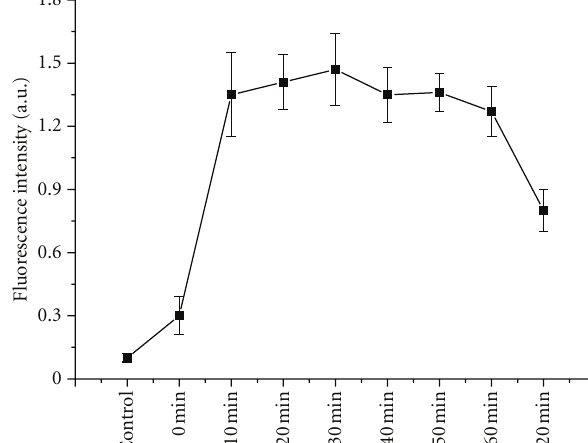
Figure 8: Change of percentage of apoptotic cells after light therapy at an intensity of 5.0 mW/cm 2 for 30 minutes in the presence of Fe- N-TiO 2 . Each data point represents mean ± SD ( n = 3). ∗ P < 0 . 05.